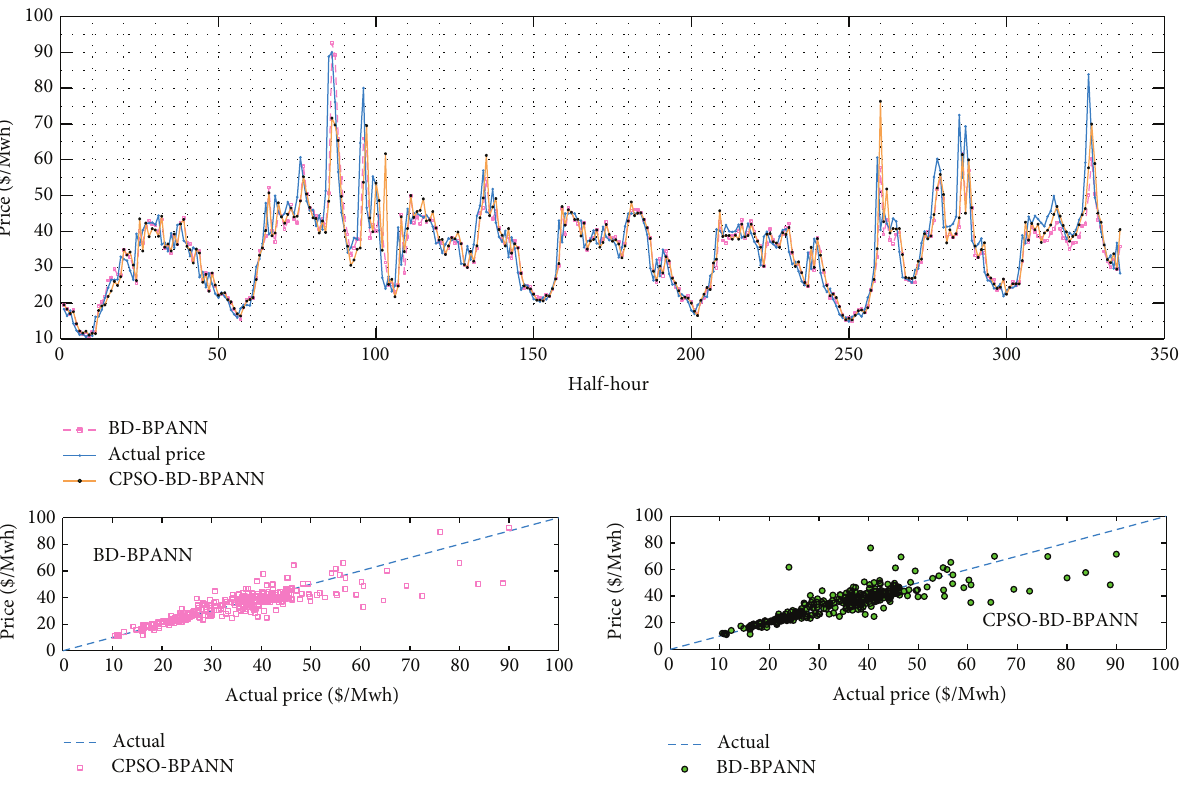
Figure 12: BD-BPANN and CPSO-BD-BPANN methods for case